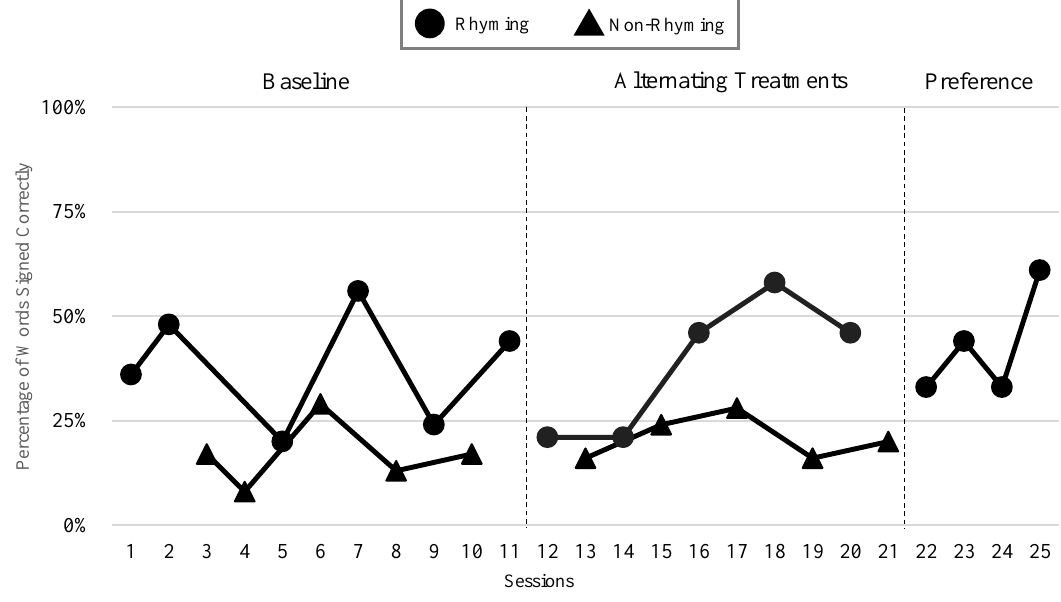
Figure 14. Jaslene’s Percentage of Words Signed in the Correct Order in Recitation.